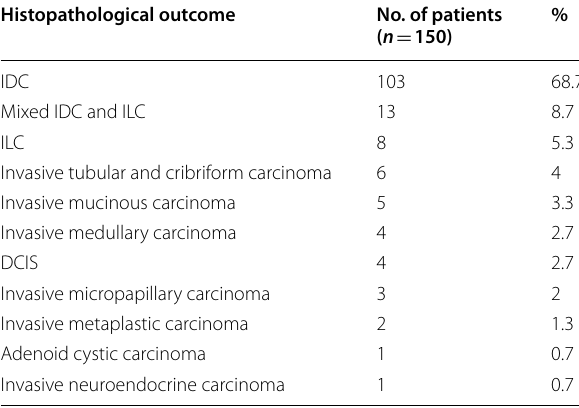
IDC; Invasive duct carcinoma, ILC; Invasive lobular carcinoma, DCIS; Ductal carcinoma in situ